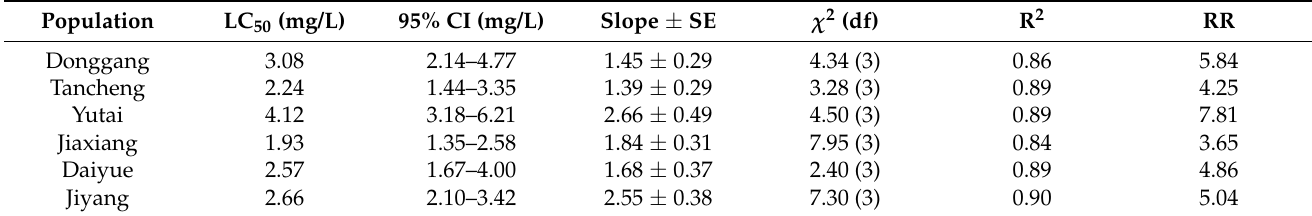
Table 4. Sensitivity to dinotefuran in six L. striatellus populations in Shandong Province.